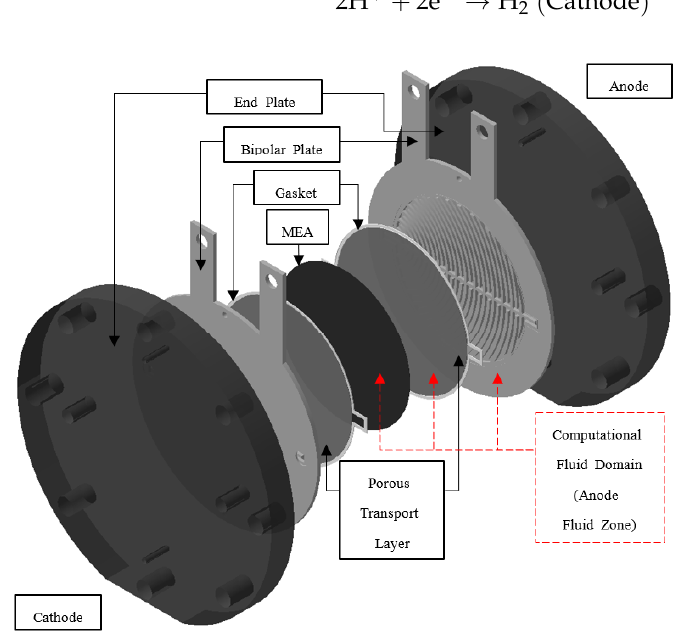
Figure 1. Schematic of the PEMWE and computational fluid domain used for this study.